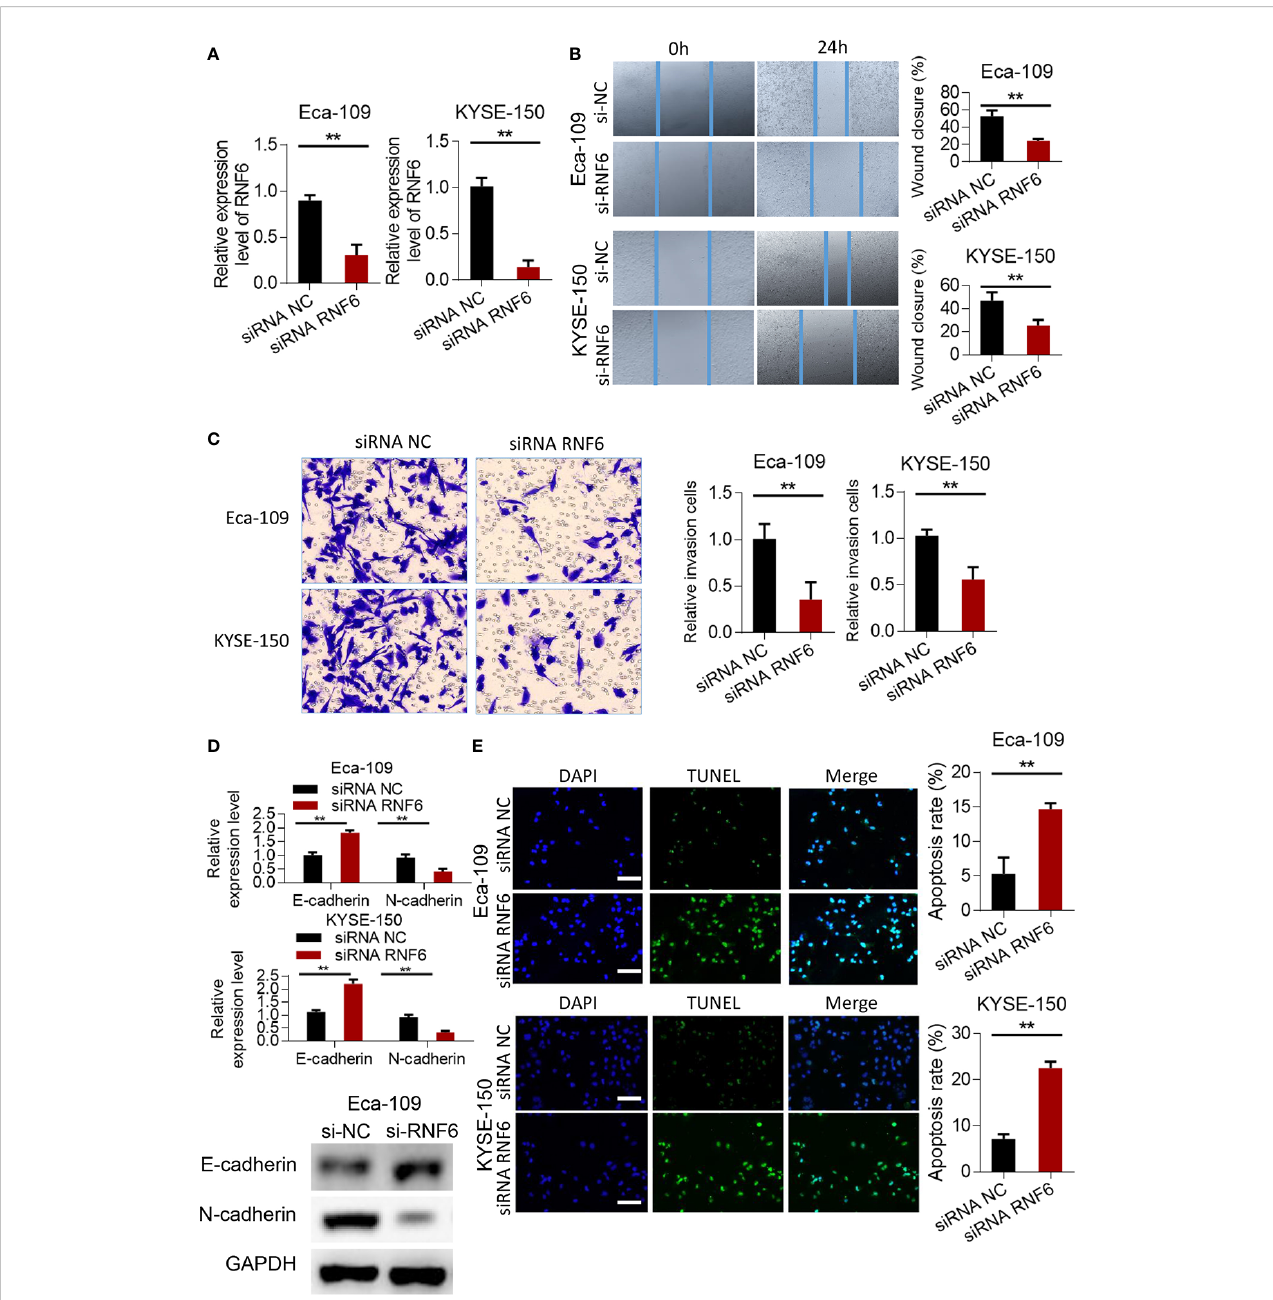
FIGURE 3 Silencing of RNF6 inhibits the migration and invasion of esophageal cancer cells. (A) Silencing ef fi ciency assay. (B) Effect of overexpression of RNF6 on wound healing. (C) Effect of overexpression of RNF6 on cell invasion. (D) Changes in E-cadherin and N-cadherin levels after RNF6 upregulation. (E) Cell apoptosis was detected by TUNEL after overexpression of RNF6. Scale bar: 50 µm. n=3, **P < 0.01, Student ’ s T test